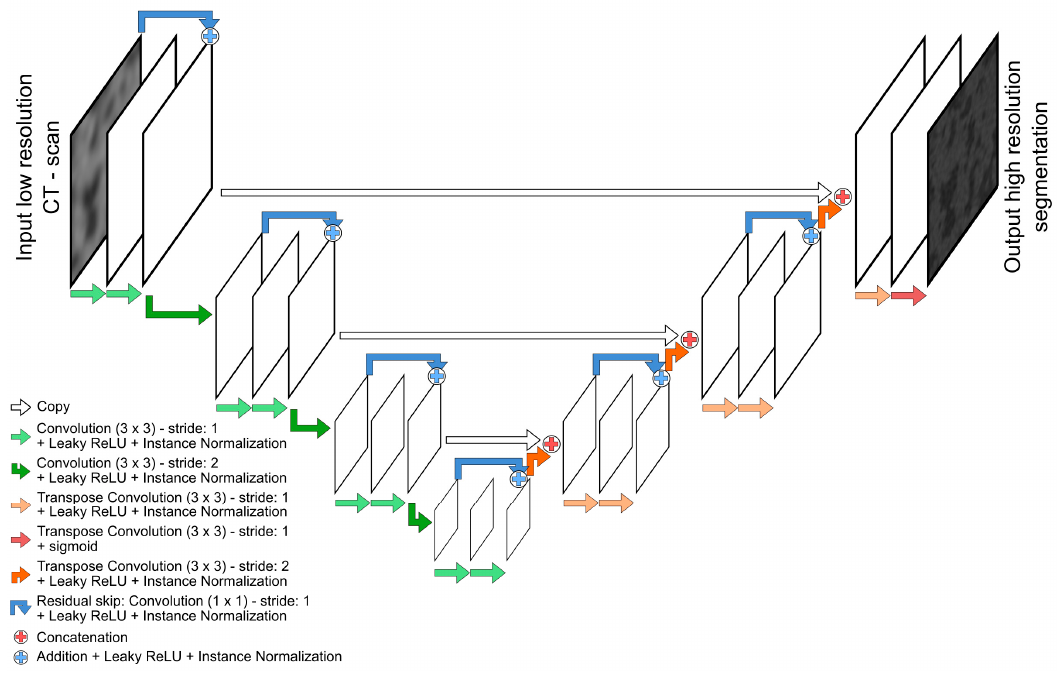
Figure 1. Fully convolutional neural network that was used for super-resolution Computed Tomography (CT) images. This sketch shows the followed path in only two dimensions, but in reality a three-dimensional approach was applied. The architecture is based on a U-Net [124], although short-range residual skips [127,129] have been added and span each convolutional block of three subsequent convolutions with as goal to speed up training.